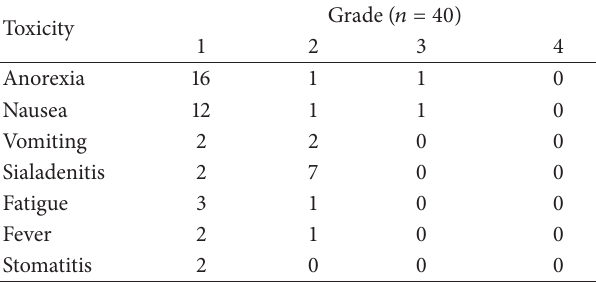
Table 1: Acute toxicities in 40 patients with refractory or relapsed neuroblastoma treated with I-131 MIBG at a mean dose of 10.5 mCi/kg in our